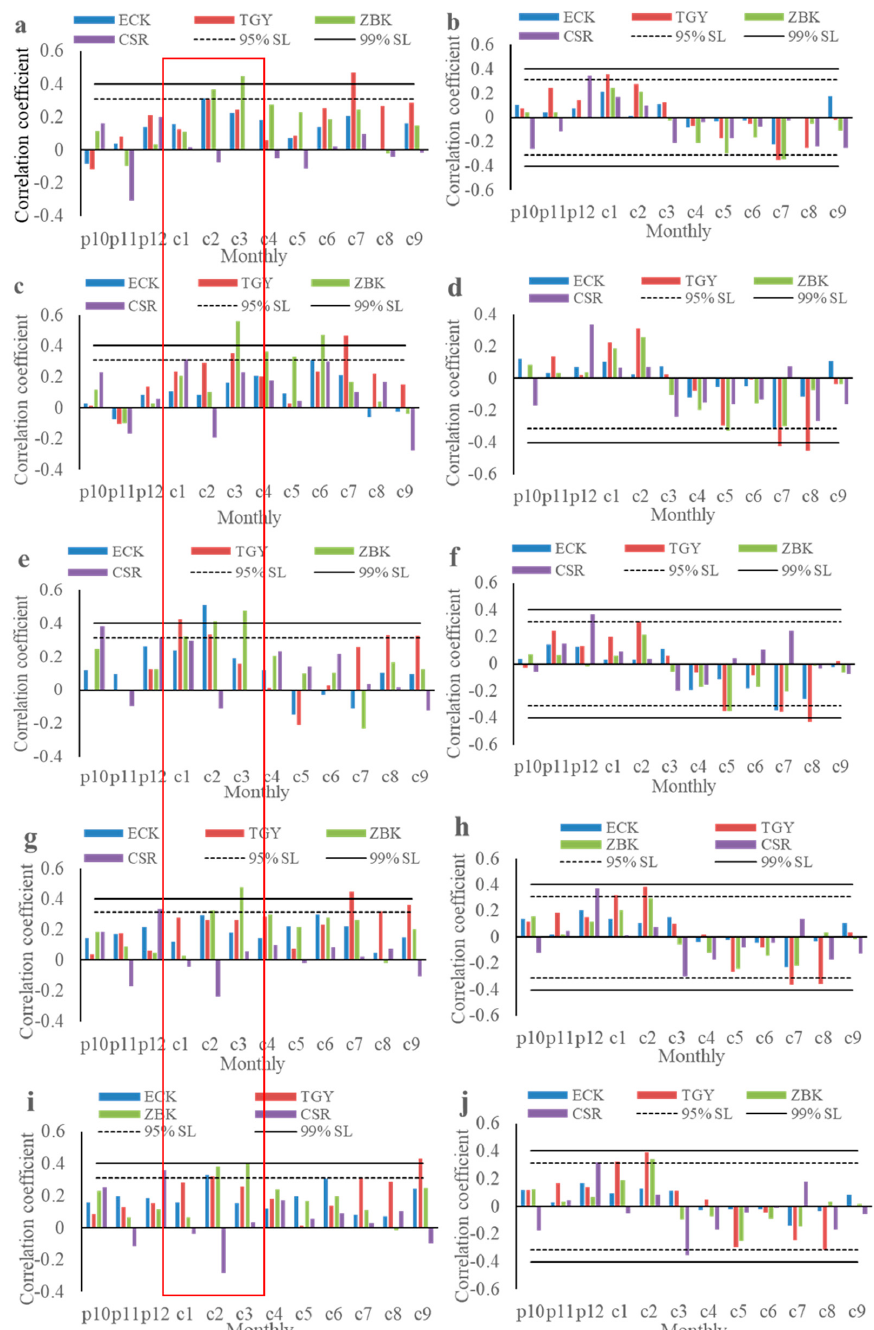
Figure 2. Correlation coefficients between the radial growth of trees and climate parameters in Kazakhstan (1977–2015). ( a ) Monthly precipitation at Almaty station; ( b ) monthly temperature at Almaty station; ( c ) monthly precipitation at Zhalanash station; ( d ) monthly temperature at Zhalanash station; ( e ) monthly precipitation at Assy station; ( f ) monthly temperature at Assy station; ( g ) monthly precipitation at Ulken Almaty Lake station; ( h ) monthly temperature at Ulken Almaty lake station; ( i ) monthly precipitation at Mynzhylky station; ( j ) monthly temperature at Mynzhylky station. p10–p12 represents October–December of the previous year, c1–c9 represents January–September of the current year, respectively. The red box indicates the month in which the radial growth of trees is related to precipitation. 99% Significance level (SL) represents passing the 99% significance test, 95% SL represents passing the 95% significance